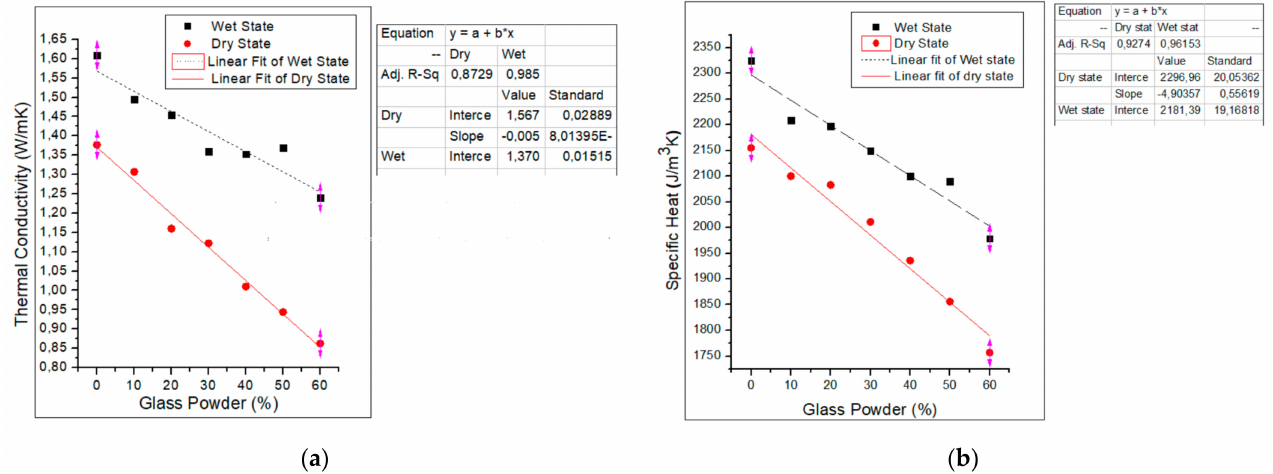
Figure 8. Variation of the measured mortars thermal conductivity ( a ) and specific heat ( b ) at dry and wet states as a function of the glass powder